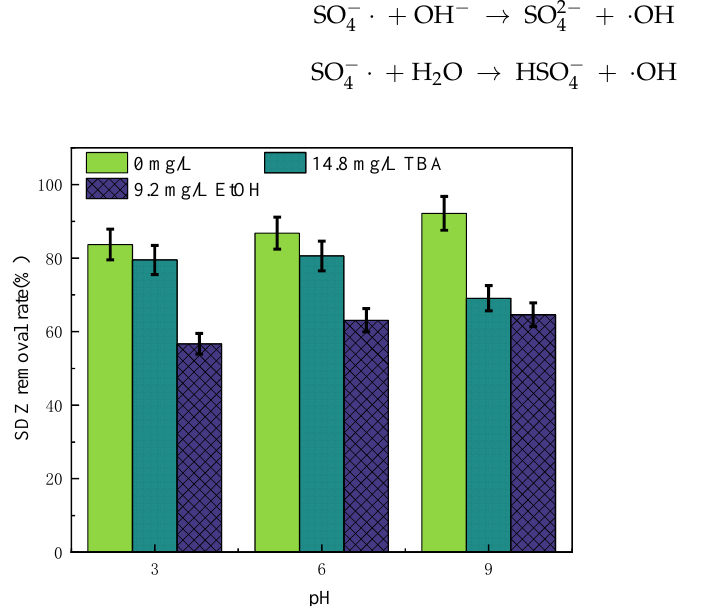
Figure 9. The effects of TBA and EtOH on the degradation of sulfadiazine by O 3 /PMS at different pH levels (reaction conditions: pH = 3, 6, 9, SDZ = 10 mg/L, O 3 = 3 mg/L, T = 25 ± 0.5 °C, O 3 = 3 mg/L, PMS = 22.8 mg/L, TBA = 14.8 mg/L, EtOH = 9.2 mg/L).